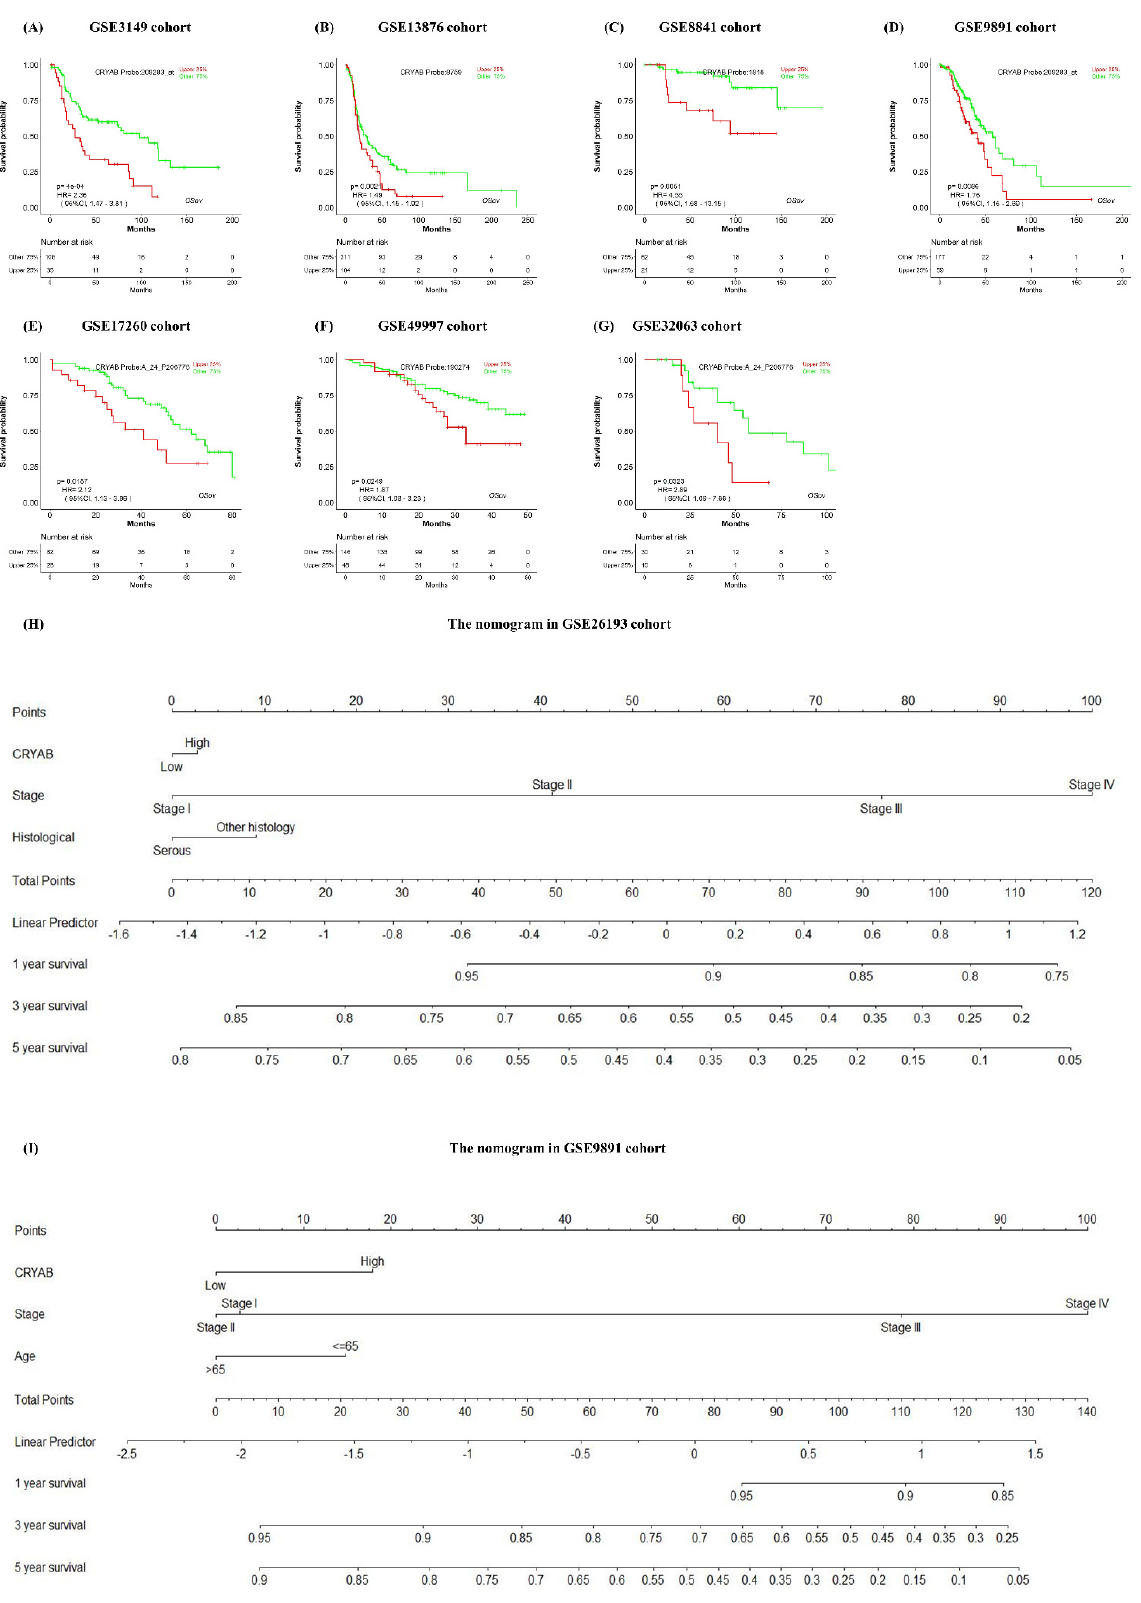
Figure 3. CRYAB is prognostic in ovarian cancer by OSov. ( A – G ) the overall survival (OS) analysis for CRYAB gene in GSE3149, GSE13876, GSE8841, GSE9891, GSE17260, GSE49997 and GSE32063 cohort, respectively; ( H , I ) the nomograms for CRYAB gene in GSE26193 and GSE9891, respectively. CRYAB: crystallin alpha